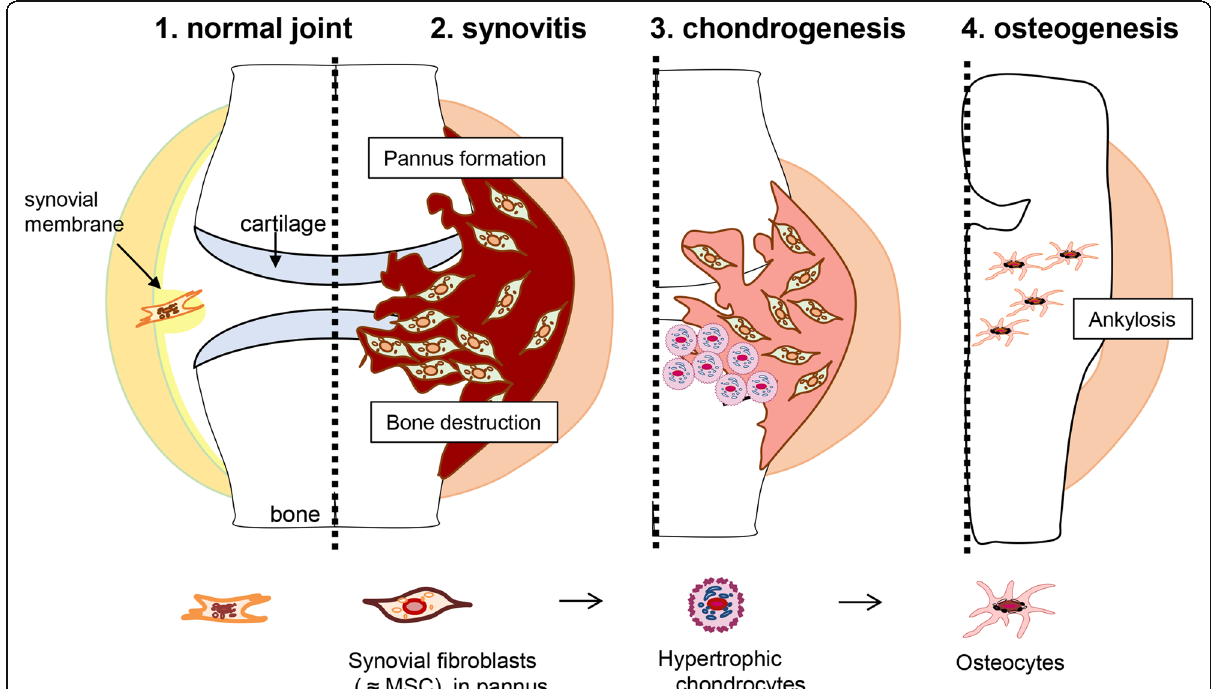
Fig. 6 Schematic representation of the stages of RA in D1BC mouse model [16]. 1: Synovial membranes, which consist of one to three cell layers, are the origin of synovial fibroblasts. 2: Joint inflammation induces aggressive proliferation of synovial fibroblasts, followed by bone erosion and destruction in the inflamed joint. Synovial fibroblasts share cell lineage markers of MSCs with pre-hypertrophic chondrocytes in bColII-D1BC mice. Because the most definitive feature of synovial fibroblasts in pannus is the expression of Col10a1 mRNA, but not its transcribed protein, ColX, these are defined as pre-hypertrophic chondrocytes. Thus, a subpopulation of synovial fibroblasts ( B7.1 , Col2a1 , Runx2 , Sox9 , Col10a1 , and Osx) differentiates into ColX-negative hypertrophic chondrocytes. 3: Synovial fibroblasts differentiate into hypertrophic chondrocytes by hypertrophic cartilage remodeling in the process of endochondral bone formation. 4: When hypertrophic chondrocytes terminally differentiate into osteochondrocytes, the expression of ColI is observed instead of ColX. A failure of cartilage remodeling leads to aberrant bone formation by ossified chondrocytes, resulting in bony